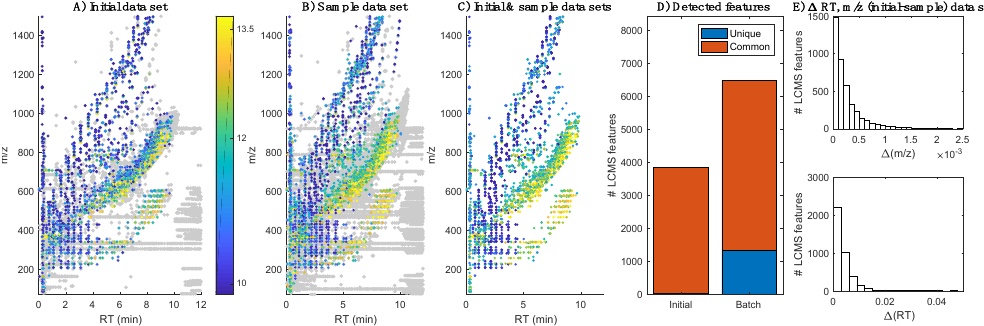
Figure 1. Distribution of background or noise features (grey dots) and informative (color dots, where the color represents the median log(intensity) in QCs) LC–MS features in the initial ( A ) and sample batches ( B ); ( C ) Distribution of features commonly detected in both data sets; ( D ) Number of unique and commonly detected features in the initial and sample batches; ( E ) Histograms of the differences in m/z (top) and RT (bottom) between features detected in both data sets.